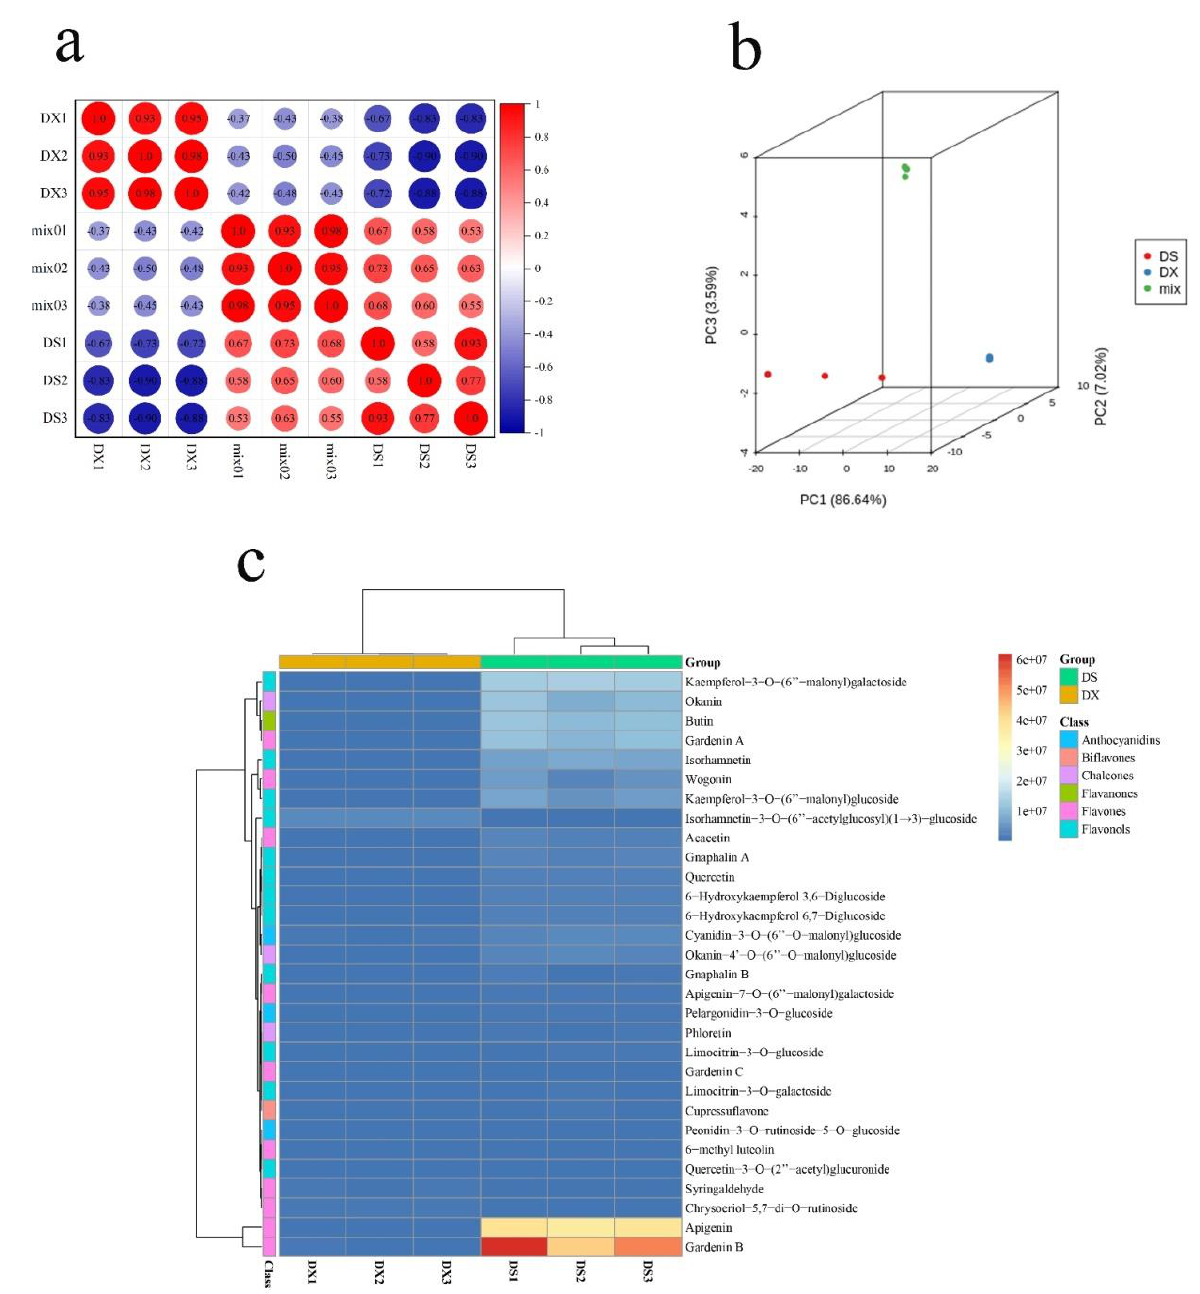
Figure 1. Heat map of main components in Gnaphalium hypoleucum DC. identified by metabolome ( a ) Correlation analysis of the G . hypoleucum DC. above-ground group (DS) and subterranean group (DX) samples, with the redder the color representing the greater correlation. ( b ) Principal component analysis of metabolomic data from above-ground (DS) and below-ground (DX) parts of G . hypoleucum DC. The “mix” refers to an equilibrium mixture of all samples (quality control) ( c ) A heat map of the identified compounds in G . hypoleucum DC. in the two groups—the colors indicates the relative content of different groups of compounds by the average peak response area by UPLC-MS, and a redder color indicates a higher relative content of the compound.